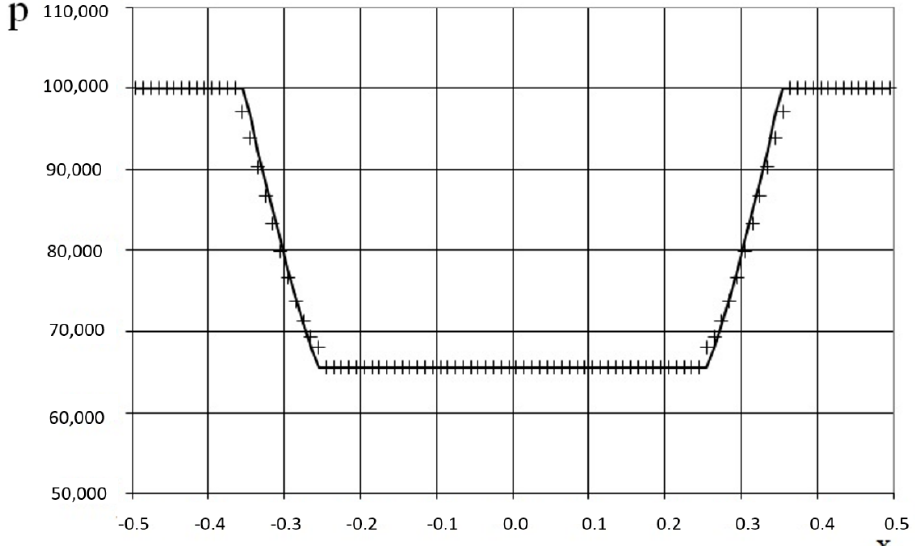
Figure 10. Pressure plot for the double expansion wave problem (47) for the adiabatic gas dynamics equations: the exact solution (line), and the present method (cross).